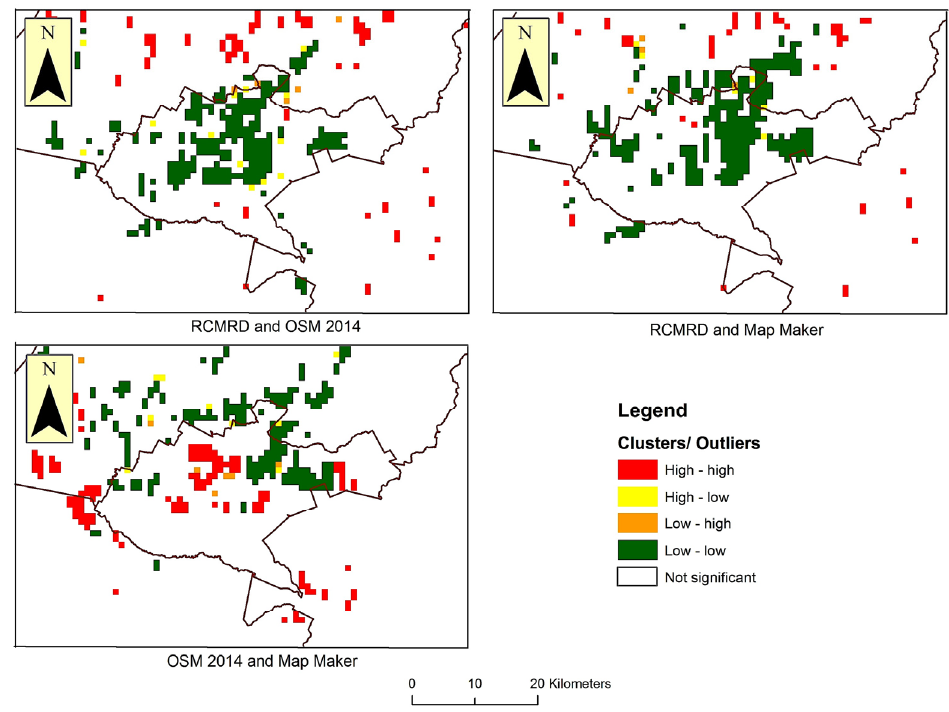
Figure 8. Cluster/outliers between road networks.